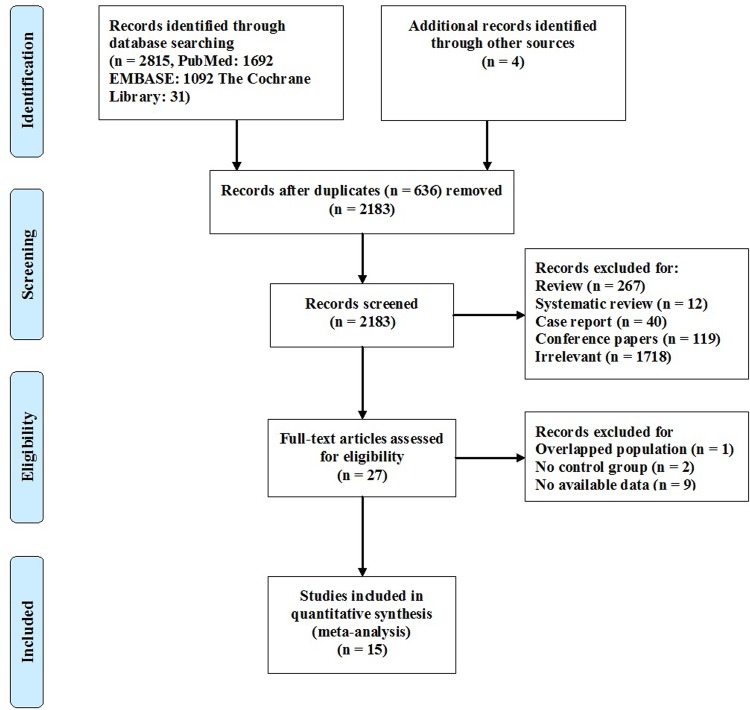
Flow diagram of the study selection process.